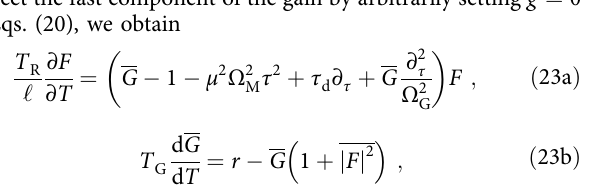
decreases the pulse shapes departs more and G 10 12 s (cid:4) 1 , T T 1 ns, ‘ ¼ 0 : 6, M ¼ 1 : 2, r ¼ 1 : G ¼ M ¼ R ¼